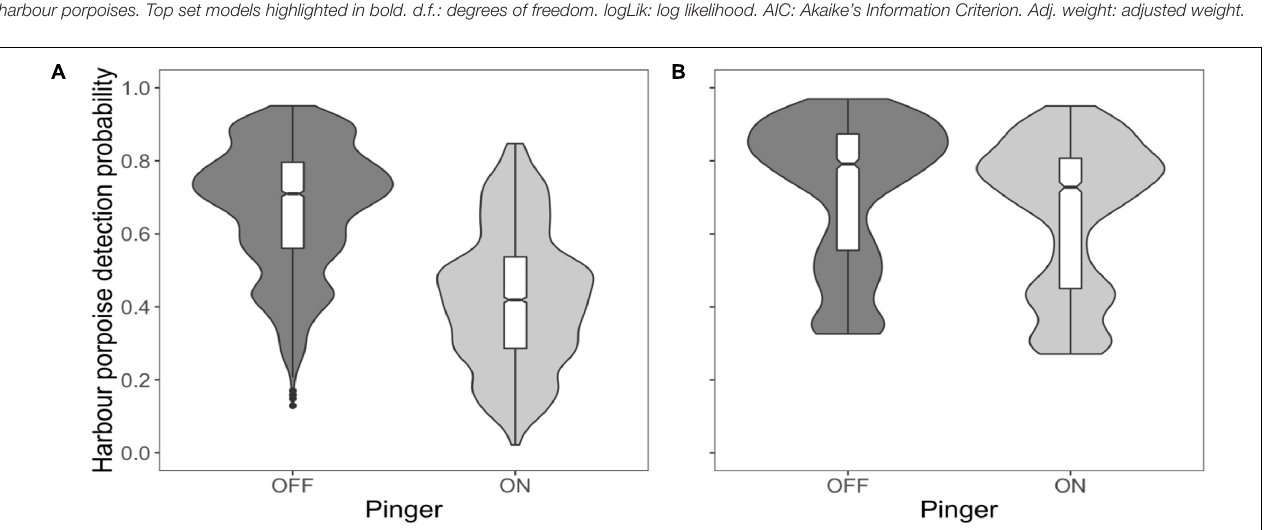
FIGURE 2 | Effect of the pinger. Probability of detecting harbour porpoises based on pinger activity at the near C-POD (A) and at the remote C-POD (B) presented as boxplots, indicating the median and interquartile range, using predictions from top ranked models presented in Table 1 . Whiskers indicate minimum and maximum values excluding outliers which are shown as dots. Violin outlines around each boxplot show kernel density of data at different